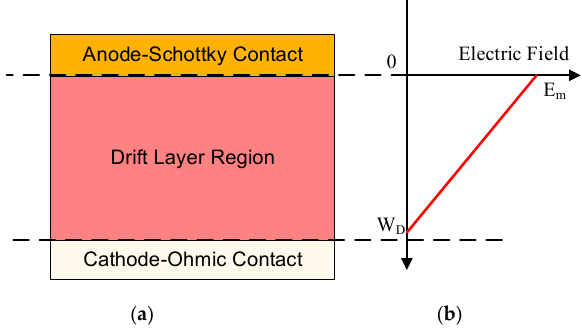
Figure 3. ( a ) Basic SBD structure and ( b ) electric field distribution.